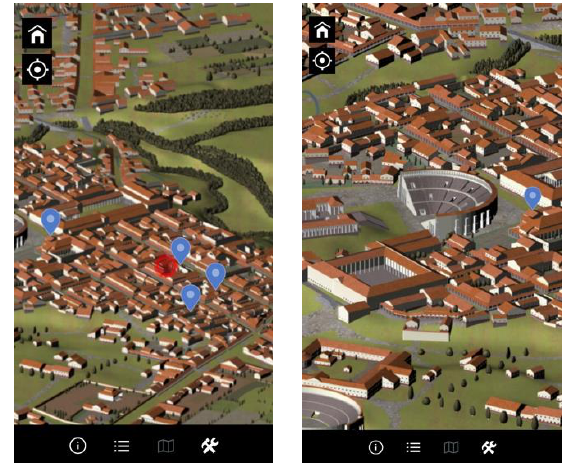
Figure 8. Image based provisioning in the Augusta Raurica App running as web-based App.